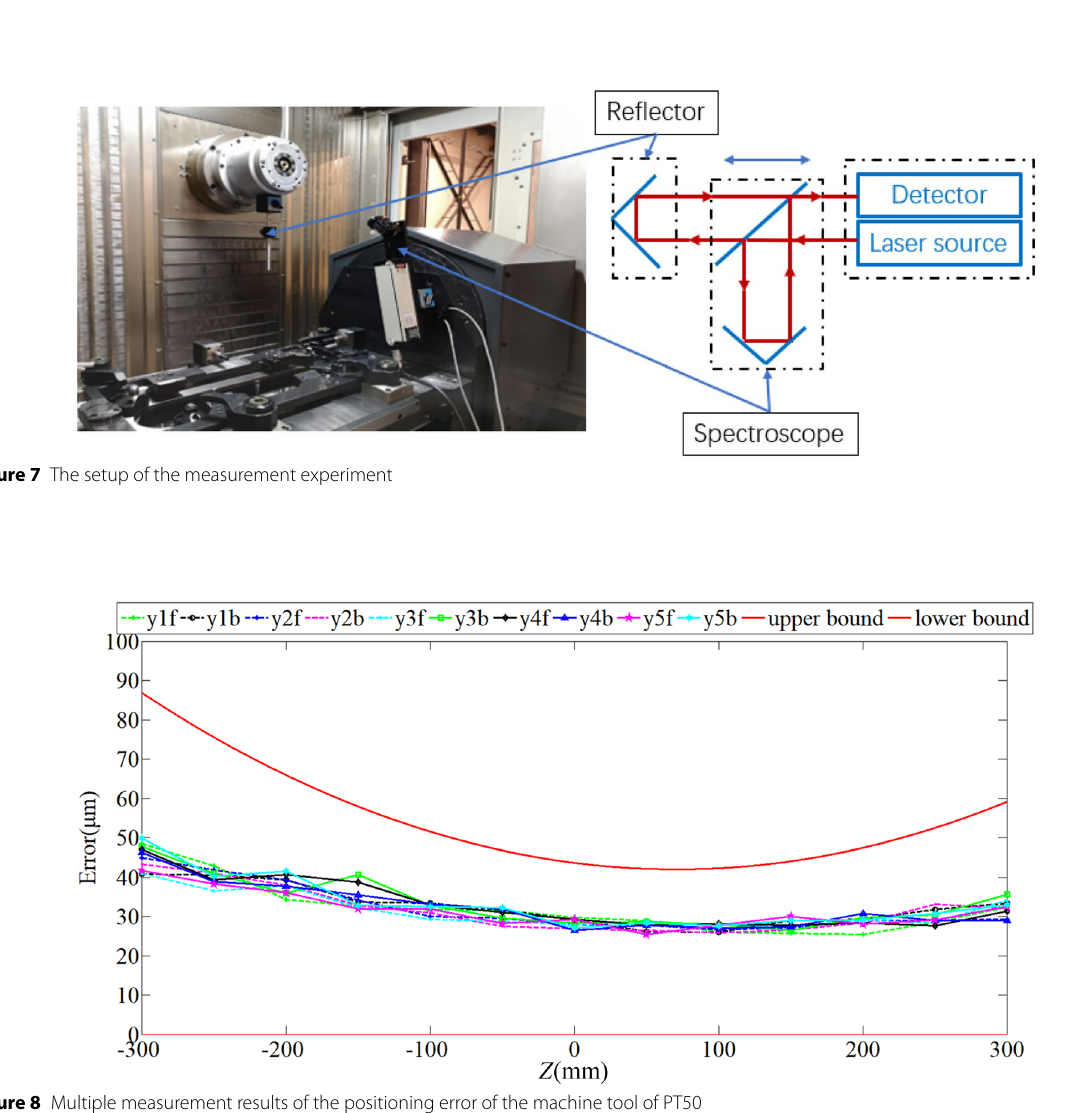
Figure 8 Multiple measurement results of the positioning error of the machine tool of